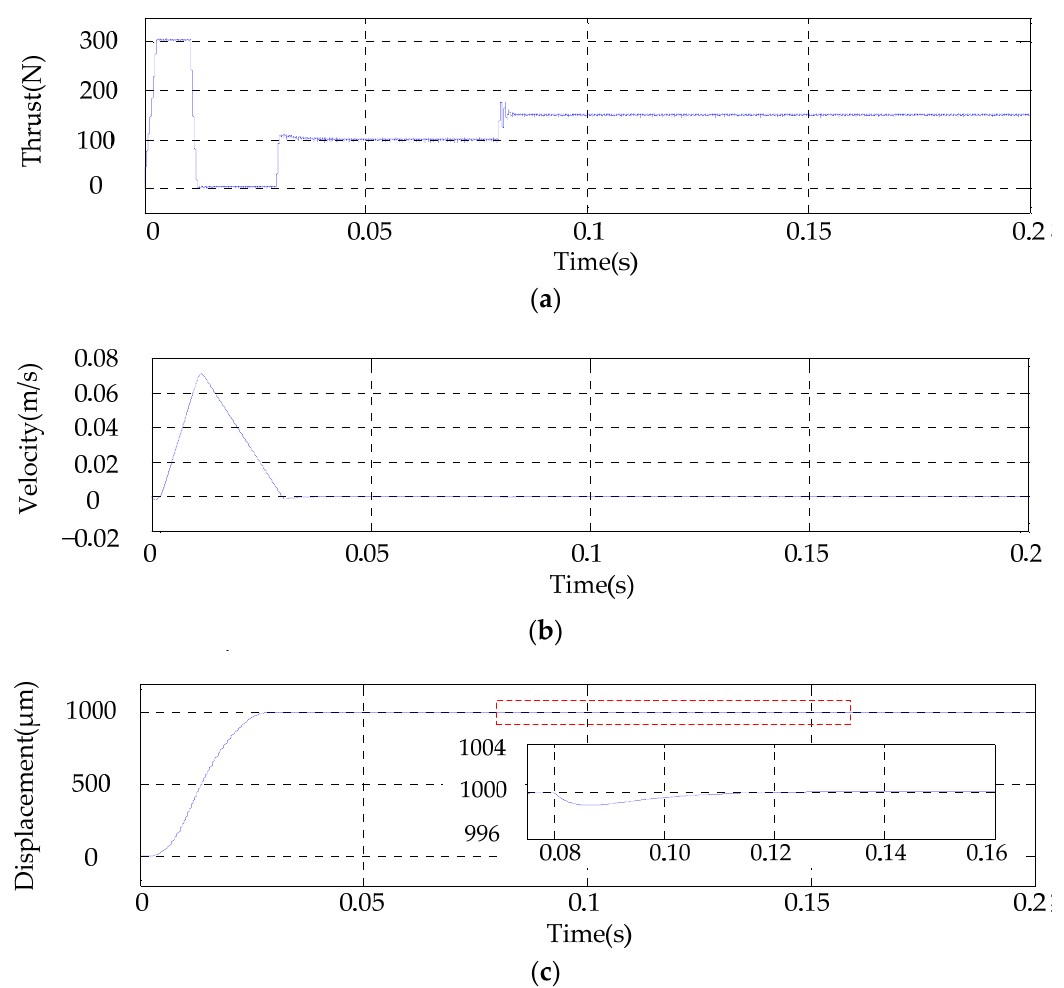
Figure 6. Y 1 Linear Motor: ( a ) Electromagnetic force; ( b ) Velocity; ( c ) Displacement in Y direction.